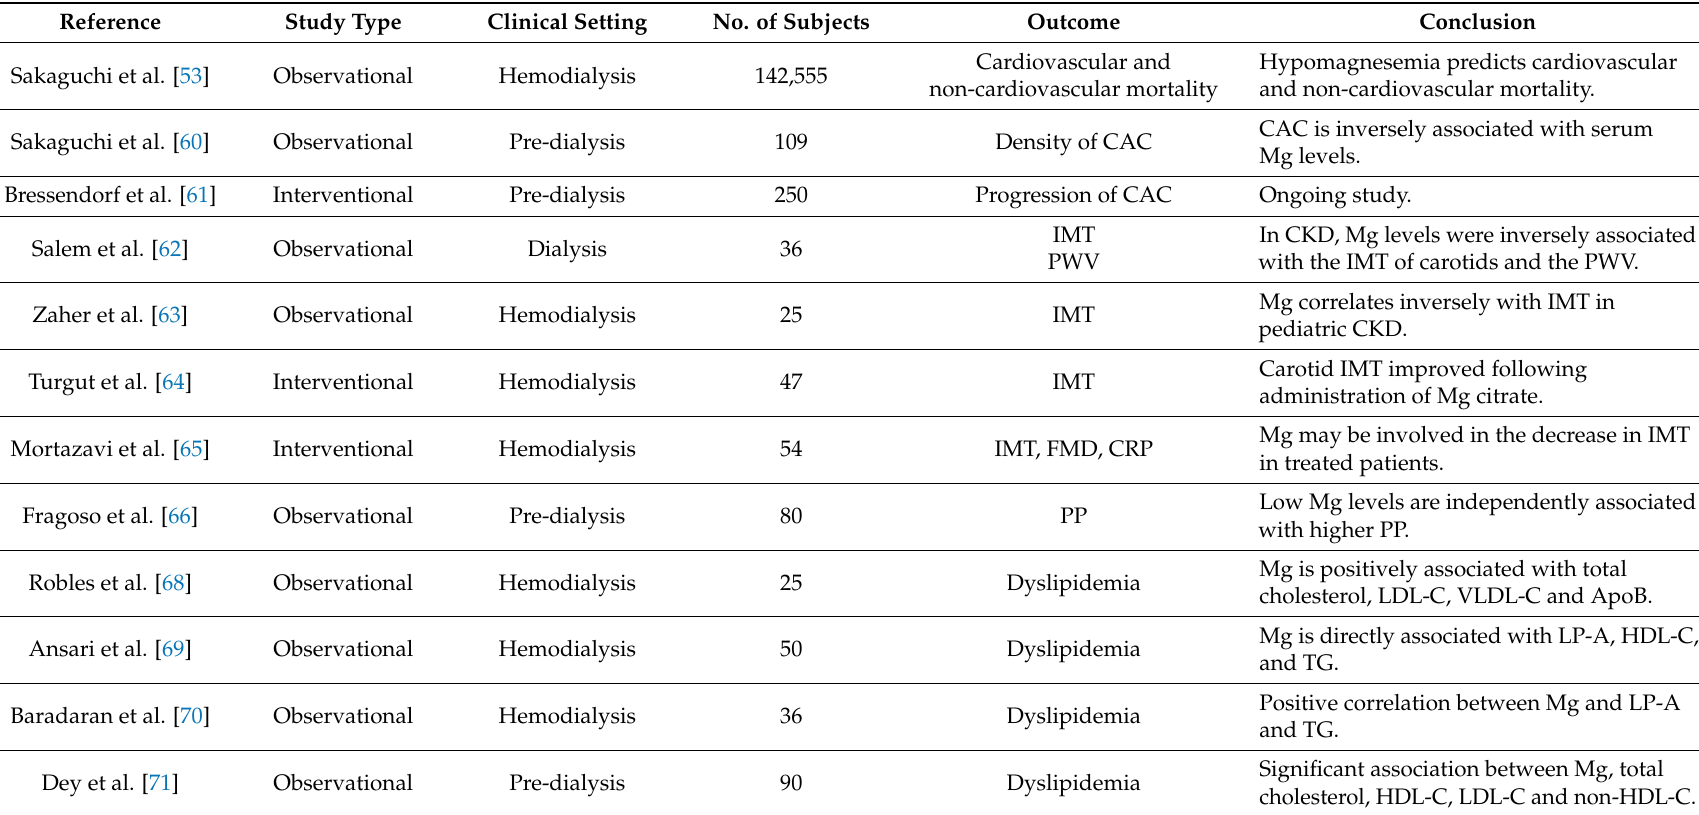
Table 2. Summary of studies evaluating the effect of magnesium on cardiovascular-related outcomes in CKD